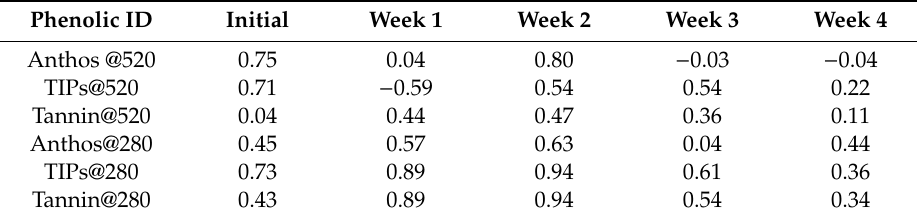
Table 2. Comparison of correlations between values obtained by assay and that same wine’s absorbance values at 520 nm as well as 280 nm at di ff erent time points after fermentation was complete. Assay data used to calculate correlation coe ffi cients was a subset of that used for modeling (n = 44).